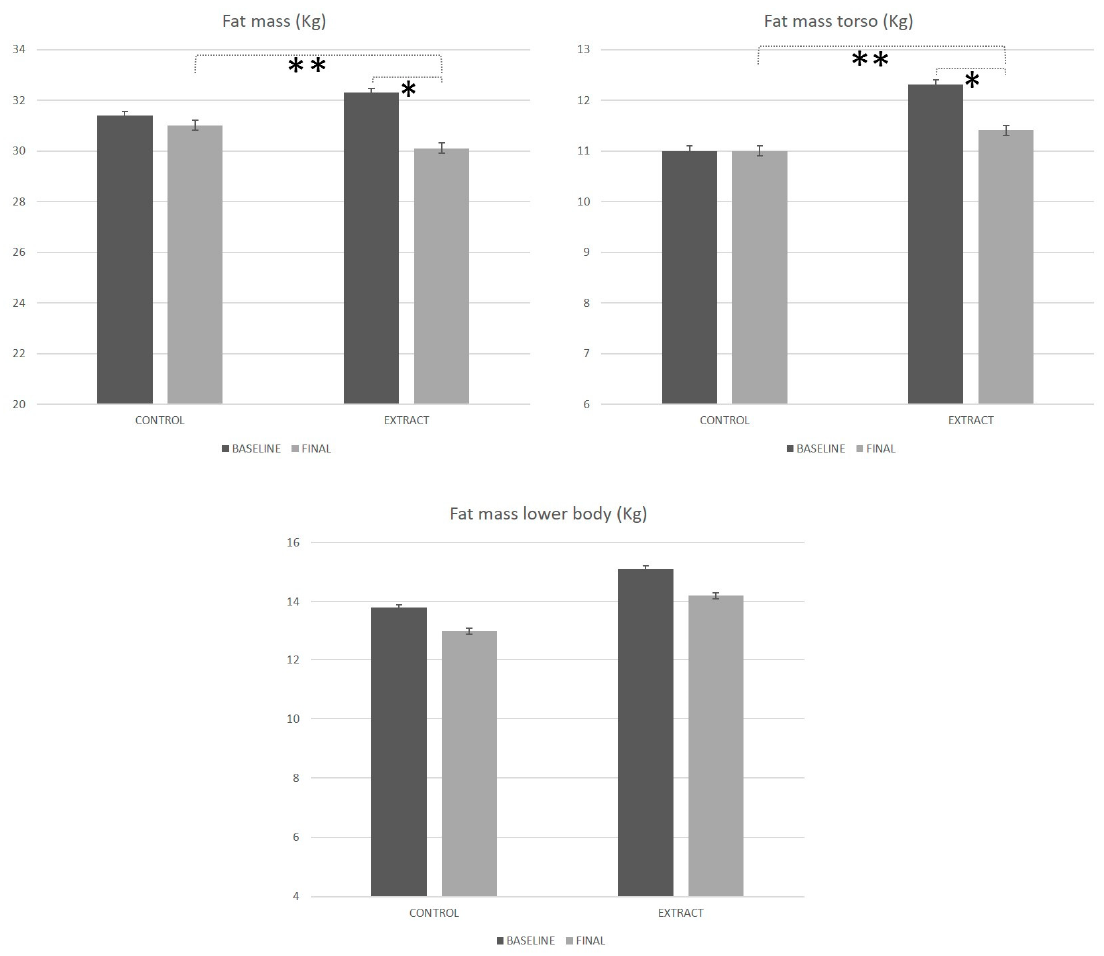
Figure 4. Body composition evolution along the study, measured by densitometry. * Means statistically significant differences. ** Mean statistically significant differences between groups.